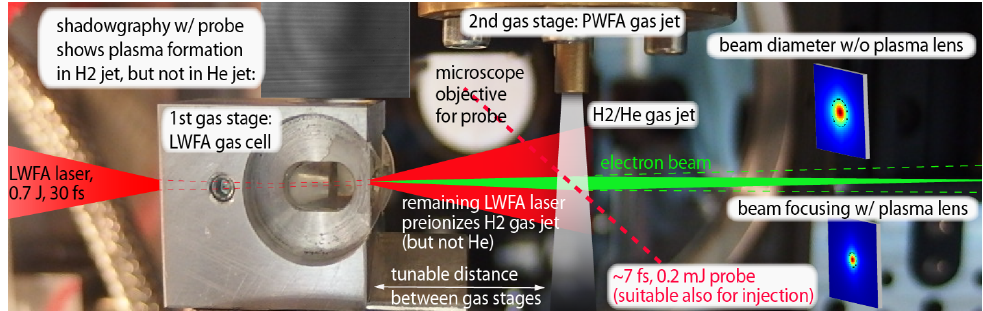
Figure 4. Hybrid setup with two separate gas targets used to show plasma-lensing of an electron beam in a second gas jet (figure adapted from [34]).